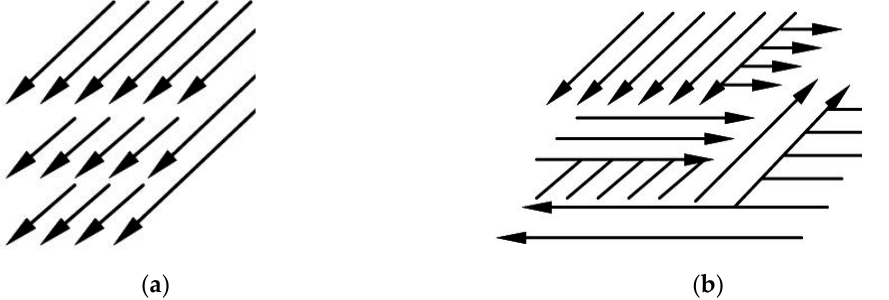
Figure 2. The scheme of the trajectory of the laser beam for various scanning strategies: ( a ) a unidirectional scanning strategy; ( b ) multidirectional scanning strategy.